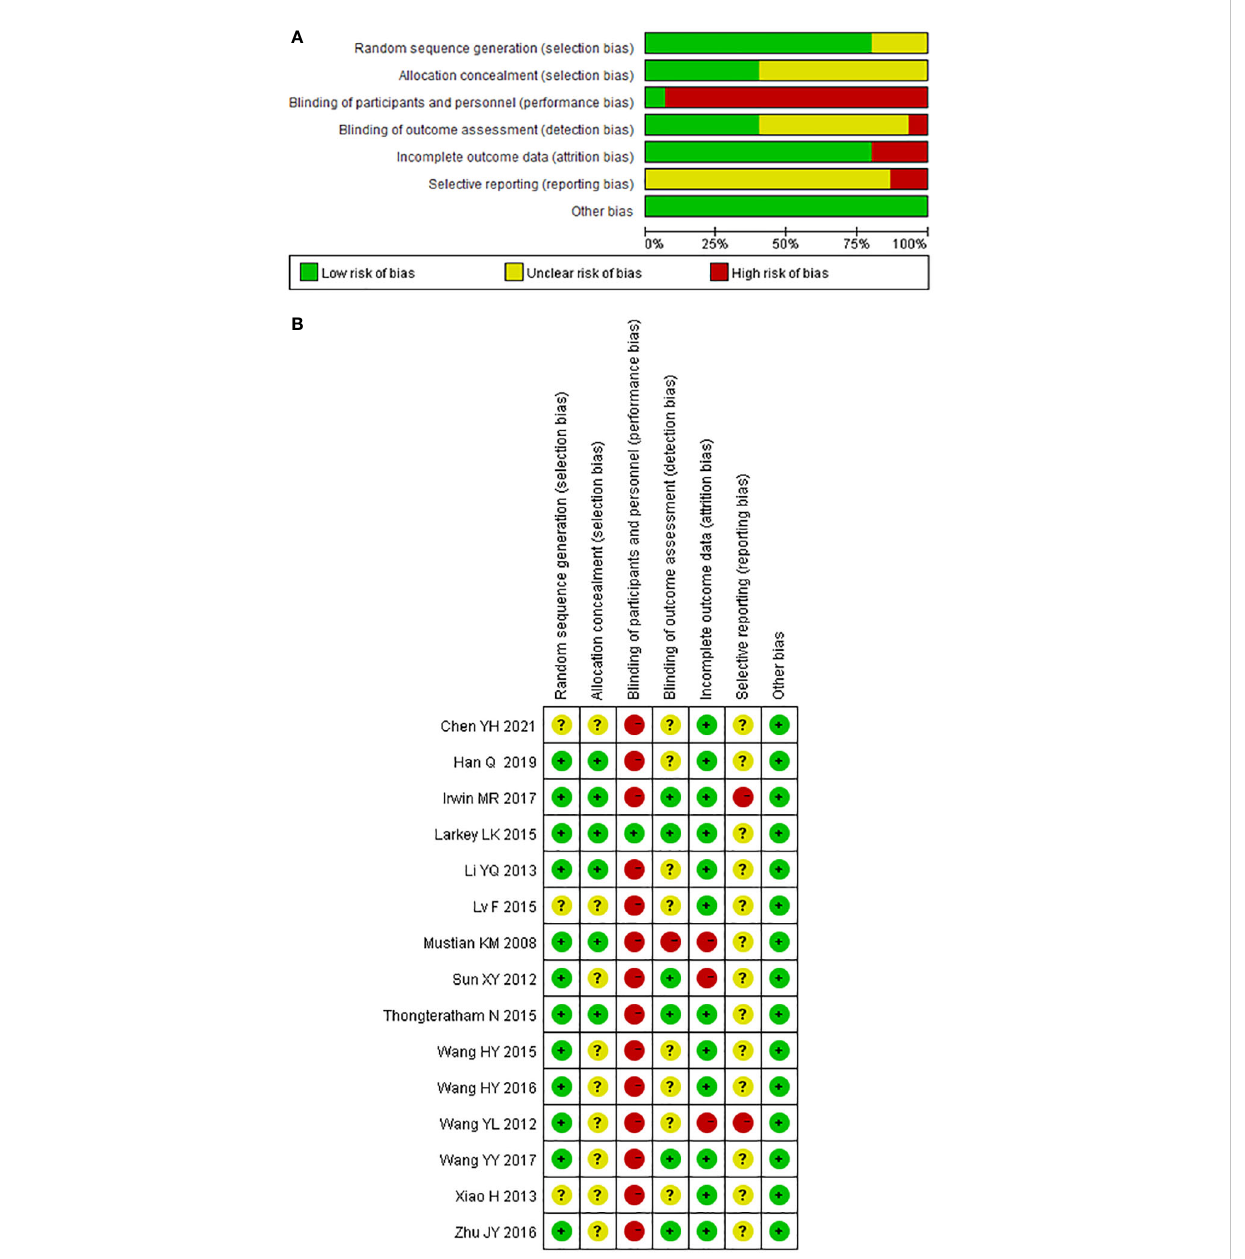
FIGURE 2 Risk of bias of included studies for the systematic review of Tai Chi Chuan training on the QoL and psychological well-being in female patients with breast cancer. (A) Risk of bias graph: the authors assessed each risk of bias item presented as percentages across all included studies. (B) Risk of bias summary: the authors judged each risk of bias item for each included study. +: low risk of bias; − : high risk of bias;?: unclear. The study ID consists of the fi rst author ’ s surname, the capital initials of the fi rst author ’ s fi rst name, and the year the fi rst report of the RCTs was published or submitted as